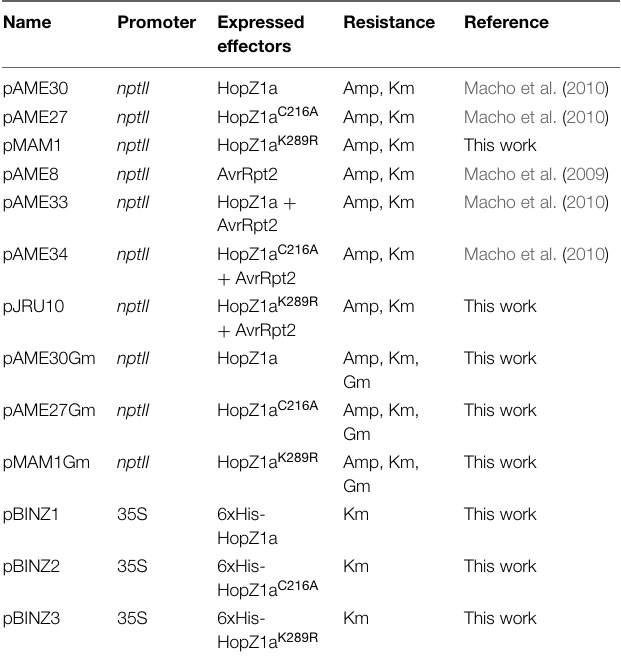
TABLE 1 | Plasmids used in this